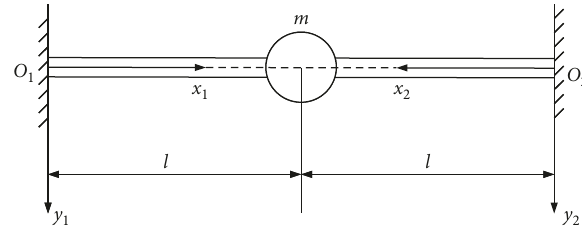
Figure 2: Coordinate systems for the resonator vibration